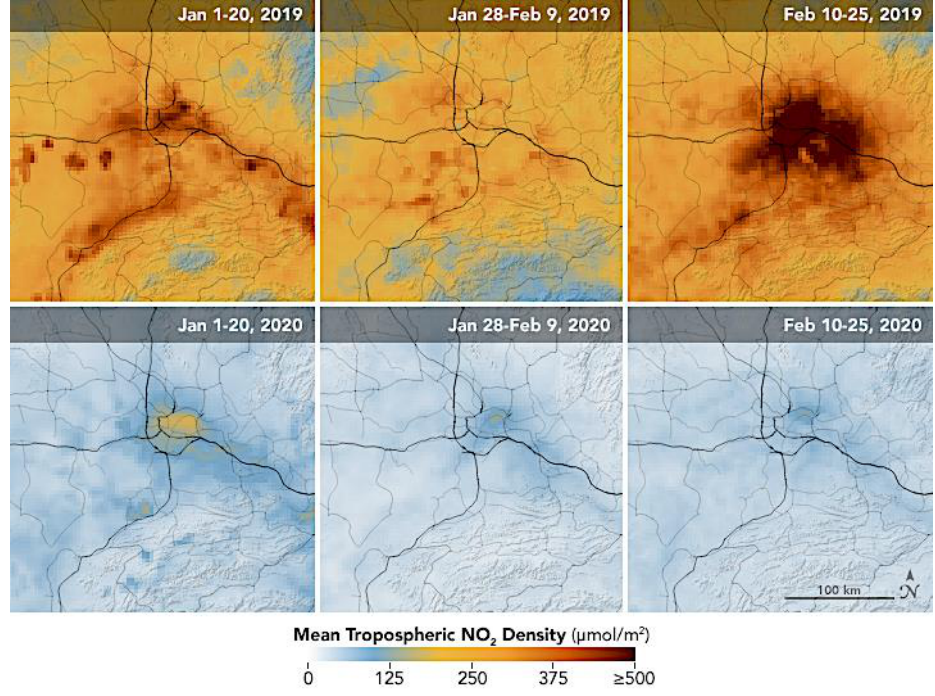
Figure 2. The satellite images show a drop in nitrogen dioxide concentration over Wuhan in China, which is a clear indication of reduced industrial activities and fossil fuel consumption due to the economic impacts of COVID – 19.